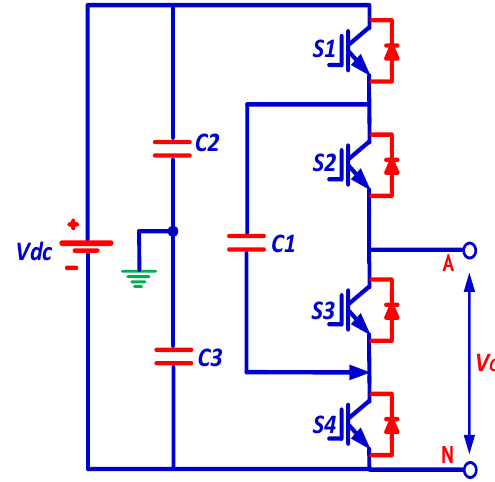
Figure 7. Three-level FCMLI topology